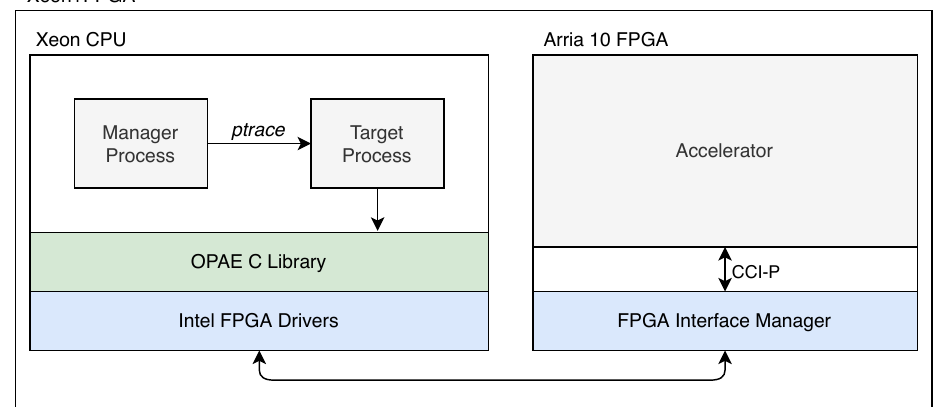
Figure 2. Architecture of the proposed